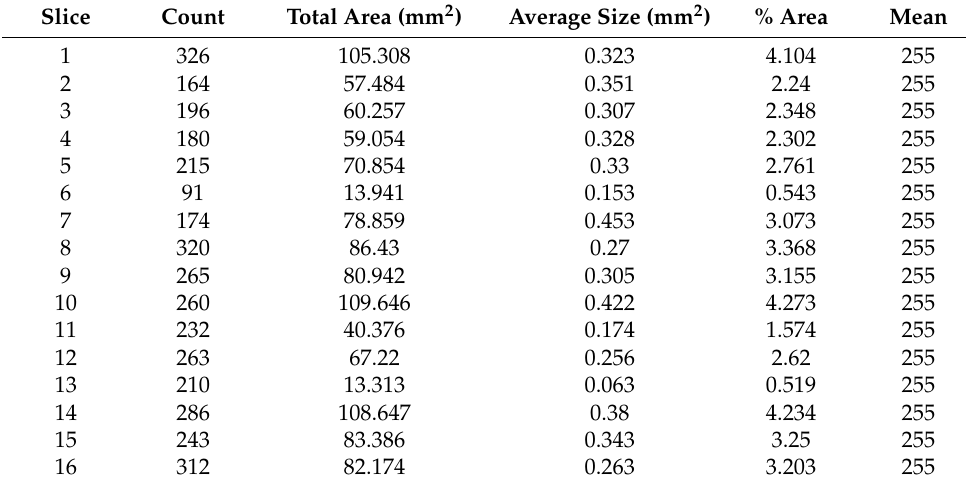
Table 6. Image analysis output.